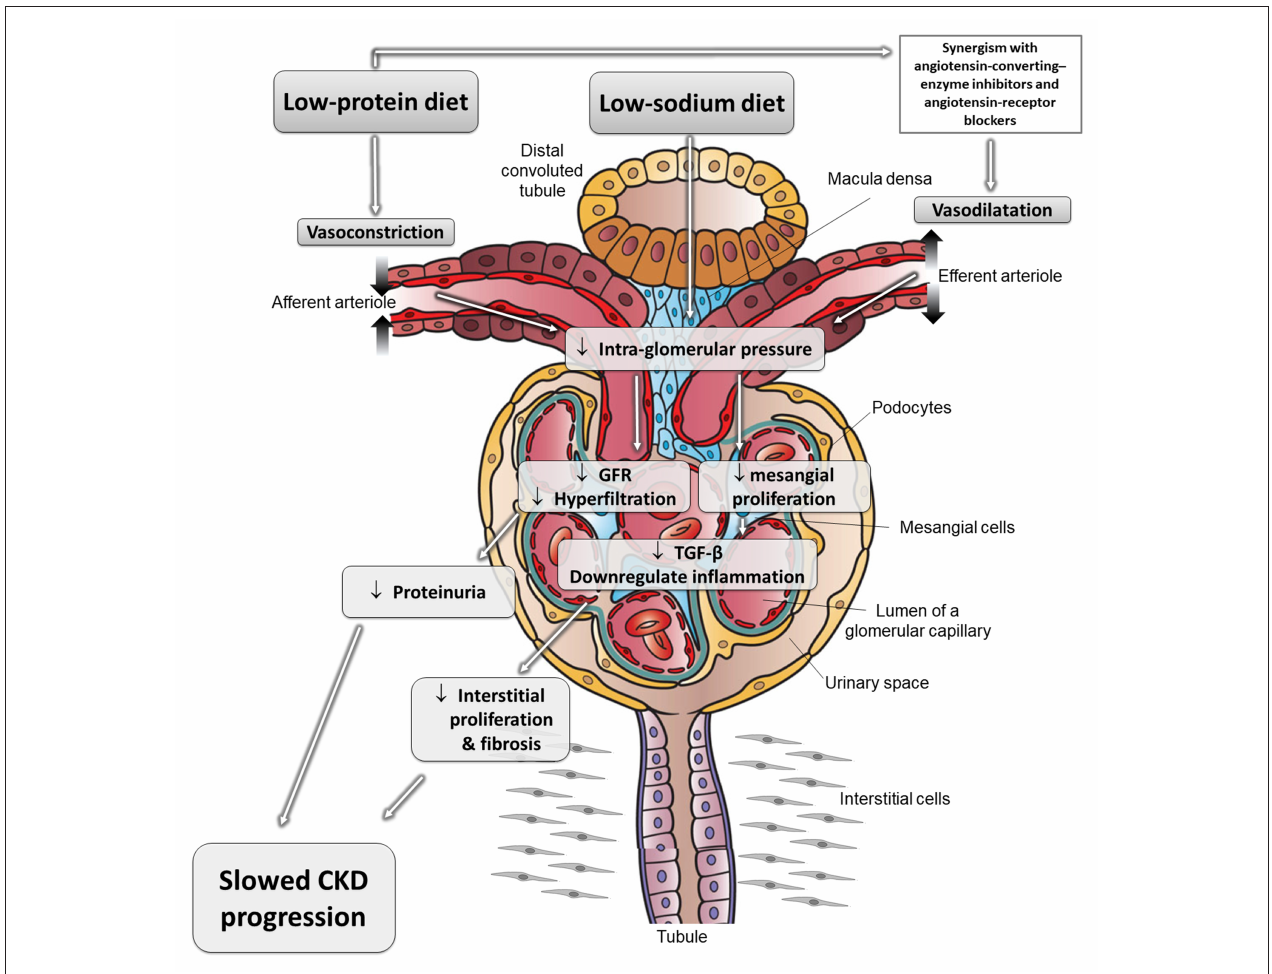
FIGURE 1 | The effects of different nutritional interventions to slow progression of CKD. Schematic representation of reno-protective mechanisms related to protein and diet restriction. These effects can be synergistic with the mechanisms of angiotensin-converting-enzyme inhibitors and angiotensin-receptor blockers, which dilate the efferent arteriole and reduce intraglomerular pressure and glomerular damage. Adapted from Kalantar-Zadeh and Fouque ( 5). CKD, chronic kidney disease; GFR, glomerular filtration rate; TGF- β , transforming growth factor